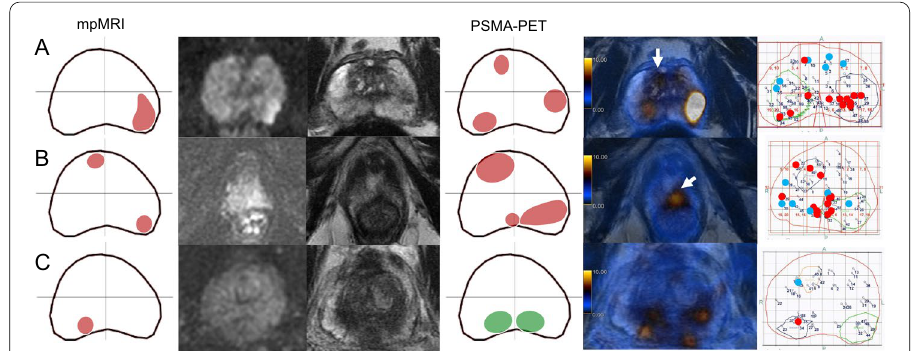
Fig. 4 Imaging and histopathological findings of cases with discordance between PSMA PET/MRI and mpMRI findings. Each line corresponds to one patient. From left to right: mpMRI readout, DWI, T2-w, PSMA PET/MRI readout, fusion PSMA PET/MRI and template biopsy map. Readouts:.lesions in red were classified by the readers as suspicious while the ones in green were classified as non-suspicious. Template biopsy maps: red dots correspond to GS 3 4 biopsy cores and blue dots to GS 3 3. A The lesion in the left posterior ≥ + + quadrant was depicted on both mpMRI and PSMA PET, corresponding to csPCa on template biopsy, but the two lesions in the right quadrants were only seen on PSMA PET (arrow in the anterior one). B PSMA PET and mpMRI were concordant regarding the lesions in the anterior right and posterior left quadrants but the apex lesion crossing the midline to the posterior right quadrant was only seen on PSMA PET (arrow). C The lesion in the right posterior quadrant was seen on mpMRI but not on PSMA PET because physiological uptake in